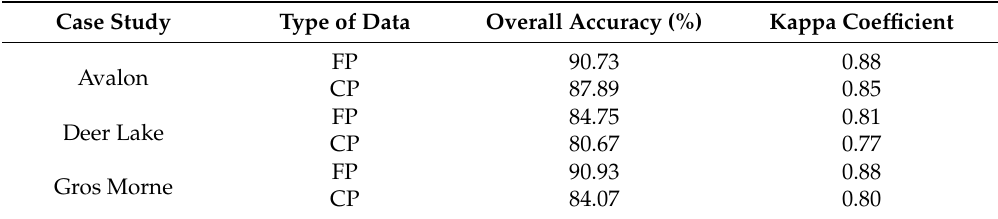
Table 4. The overall accuracies and Kappa coefficients obtained from FP and CP SAR data for the three case